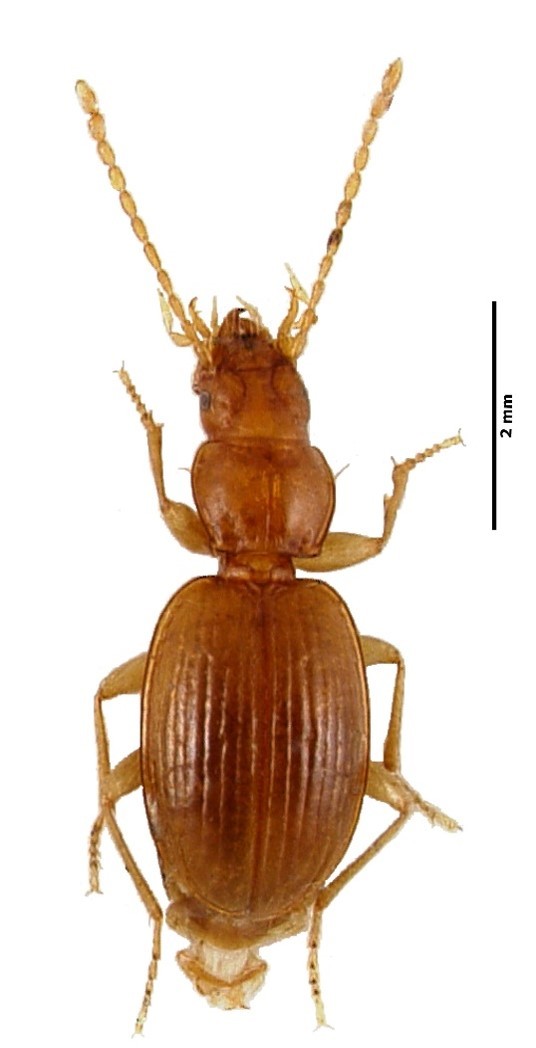
Trechus
jorgensis (Oromí & Borges, 1991) from São Jorge island (Azores, Portugal) (Credit: Enésima Mendonça, Azorean Biodiversity Group, cE3c).